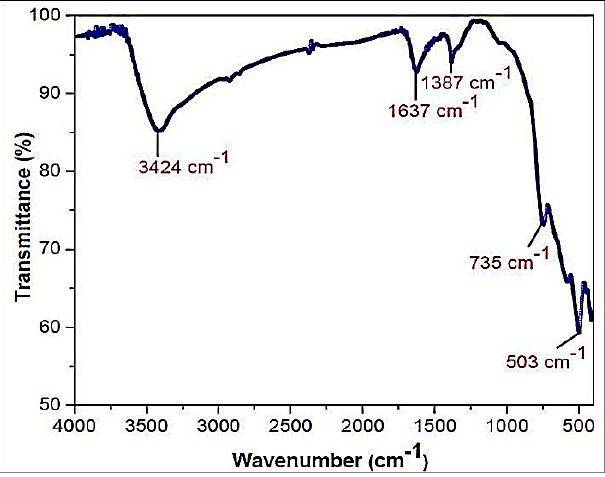
Figure 5. Transform infrared (FT-IR) spectra of ZrO 2 NPs.